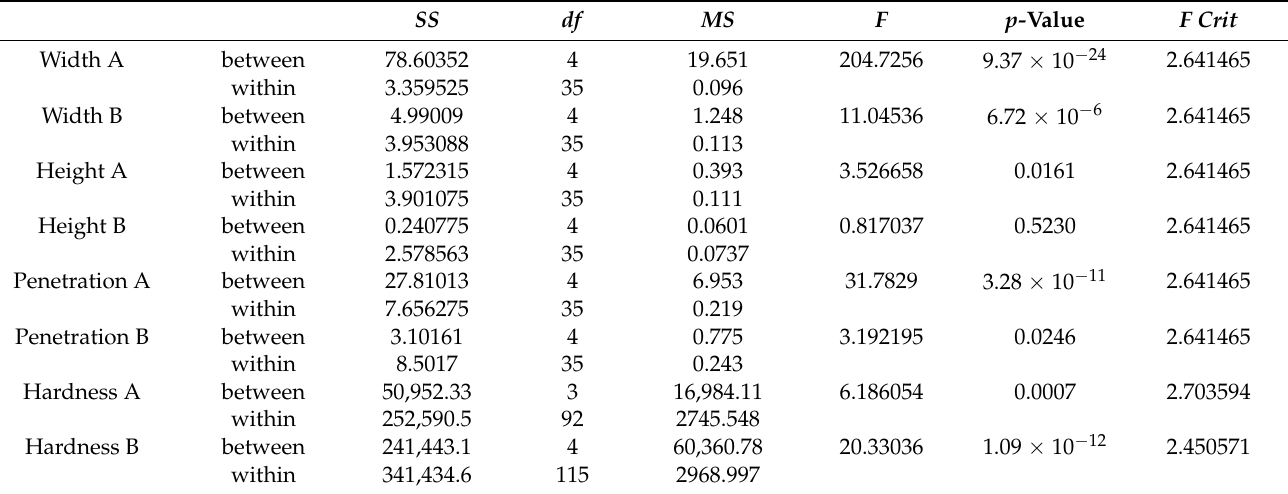
Table 6. Aggregated results from ANOVA testing.